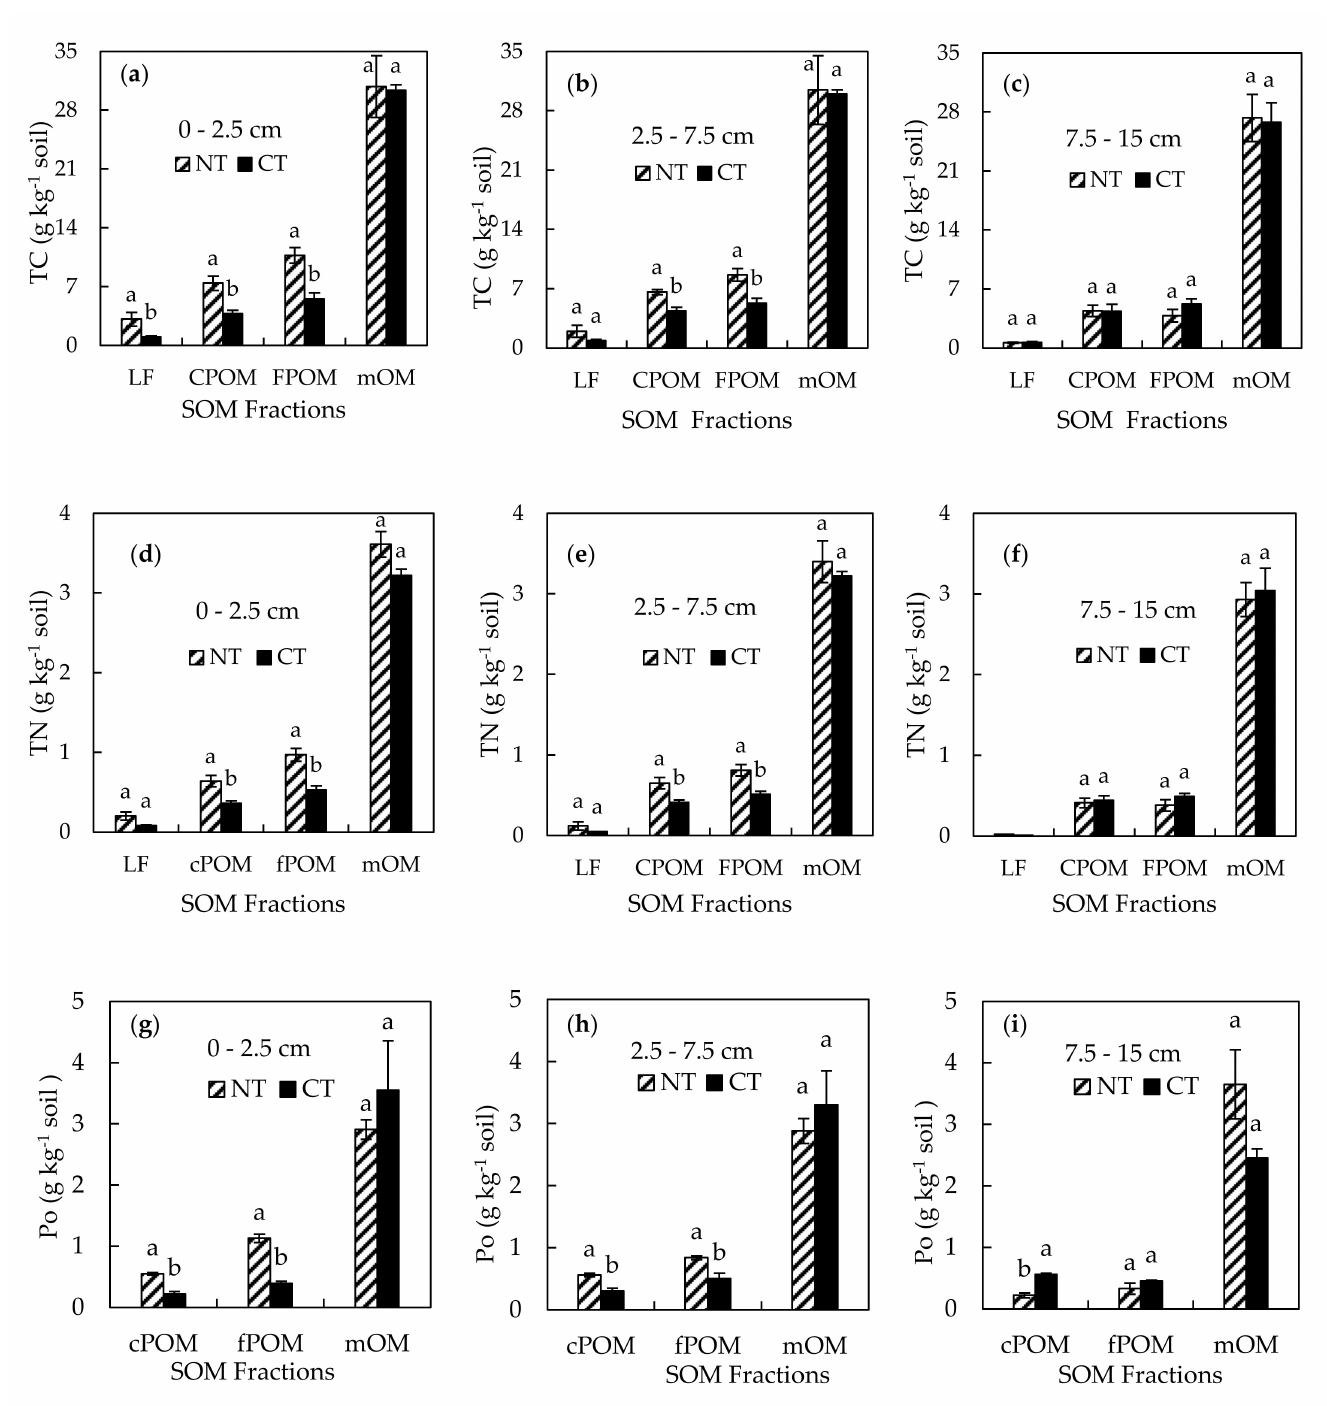
Figure 3. Total carbon (TC); ( a – c ) (g C kg − 1 soil), total nitrogen (TN); ( d – f ) (g N kg − 1 soil), and organic phosphorus (Po); ( g – i ) (g P kg − 1 soil) of SOM fractions by physical fractionation of Andosols from the no-tillage (NT) and conventional-tillage (CT) systems. Different letters show significant differences for the tillage treatments of each fraction, according to Student’s t -test ( p <